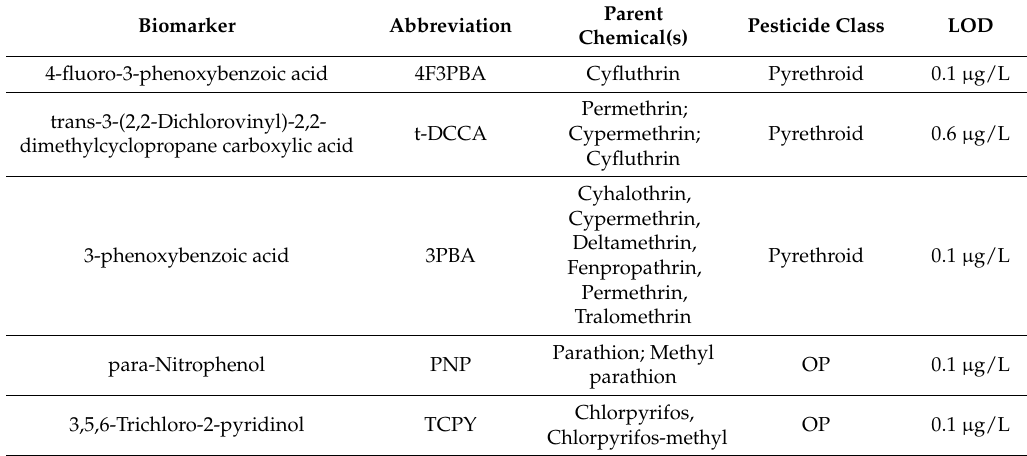
Table 1. The pesticide biomarkers measured in